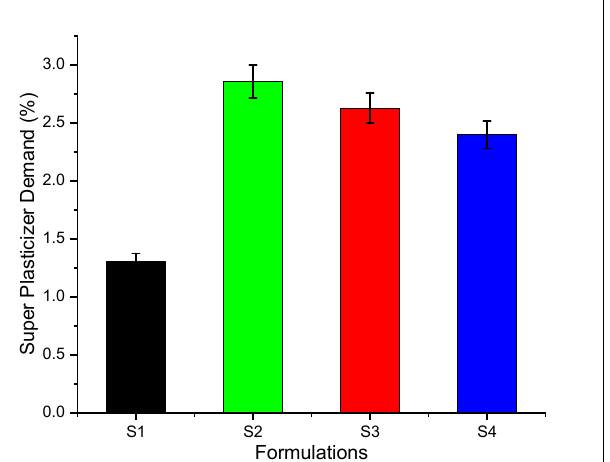
Figure 11. ( a ) T 25 and T 30 spread of hybrid nanocomposite, ( b ) total spread of hybrid nanocomposite.